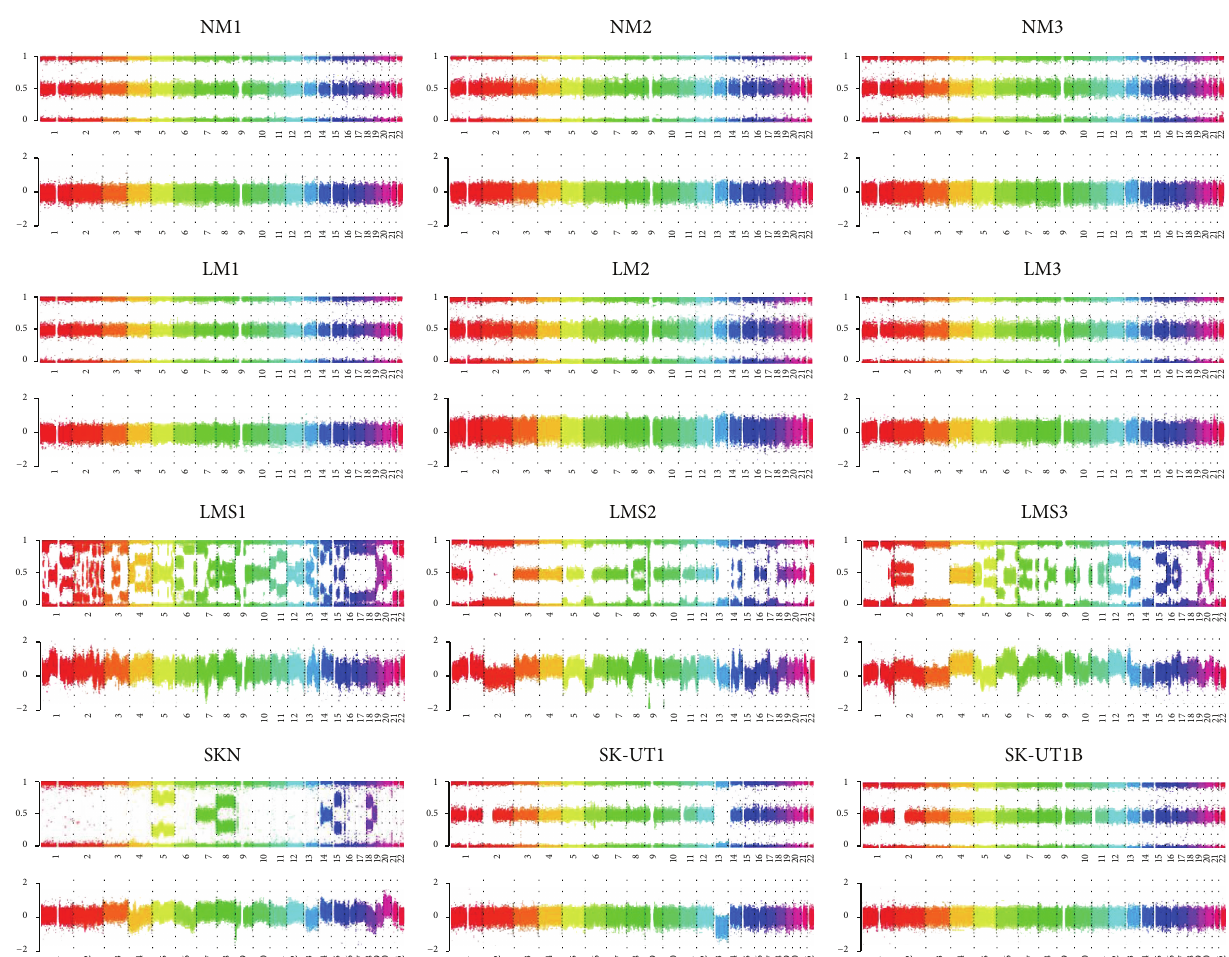
Figure 1: Chromosomal constitutions of normal metrium tissues (NM), leiomyoma (LM), and leiomyosarcoma (LMS) cases, and LMS- derived cell lines determined by SNP-array analysis. BAF (upper) and LRR (lower) are shown for 22 autosomal chromosomes of each of the 12 samples. The data ranges shown are 0 to 1 for BAF and − 2 to 2 for LRR.